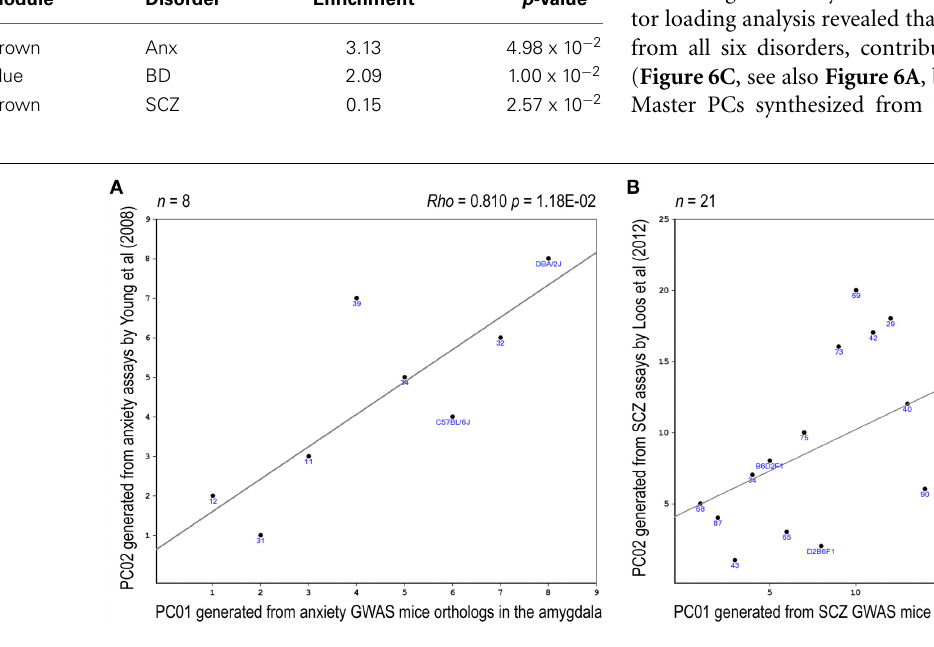
FIGURE 5 | Expression-phenotype correlations. Correlations between the top-2 synthetic PCs derived from the expression profile of the mouse orthologs of the NHGRI-cross-disorder gene set and relevant mouse behavioral phenotypes are depicted. (A) Correlation between the top PCs